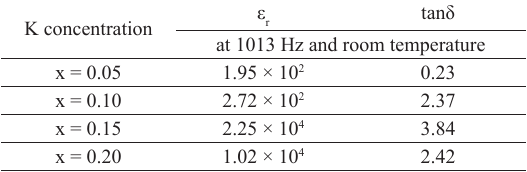
Table 2. Dielectric properties of the samples with various K